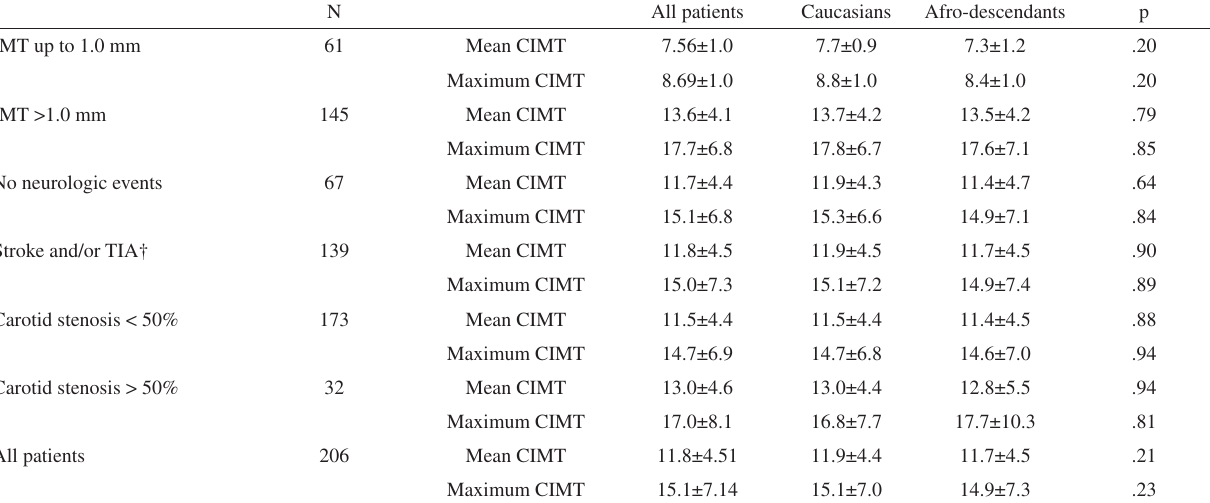
Table IV - Comparison of mean and maximum values of intima-media thickness (IMT) between Caucasians and Afro- descendants*